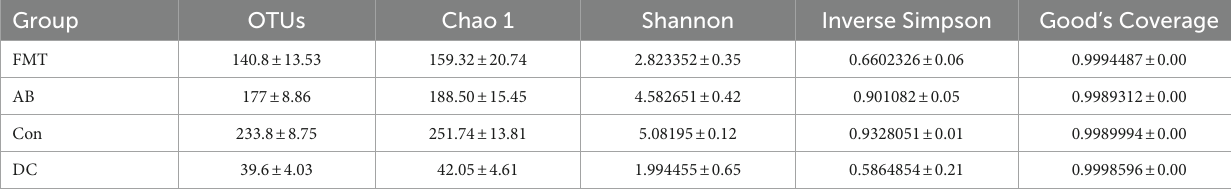
TABLE 1 Diversity and richness (mean ± SD) of the fecal bacteria communities of mice and Suncus murinus . Group